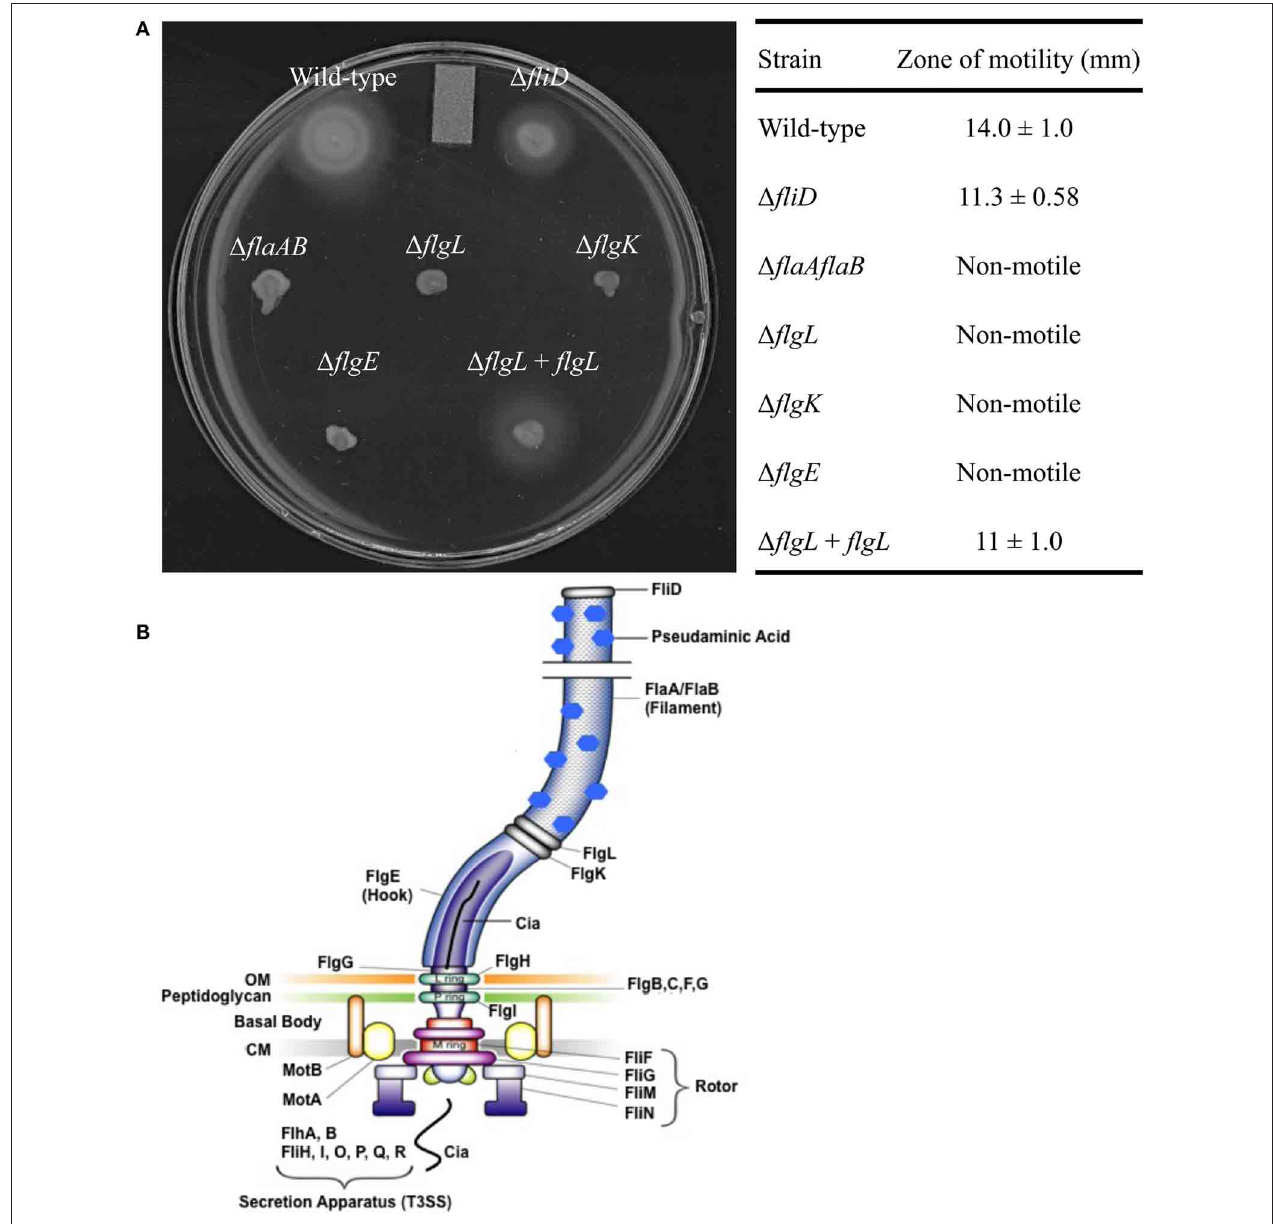
FIGURE 1 | Motility of the C. jejuni flagellar mutants. Motility assays were performed using C. jejuni F38011 wild-type strain, the isogenic fliD, flaAflaB, flgL, flgK , and flgE mutants, and the flgL mutant complemented with flgL (A) . The table contains zones of motility ± one standard deviation obtained from a quantitative motility assay performed in